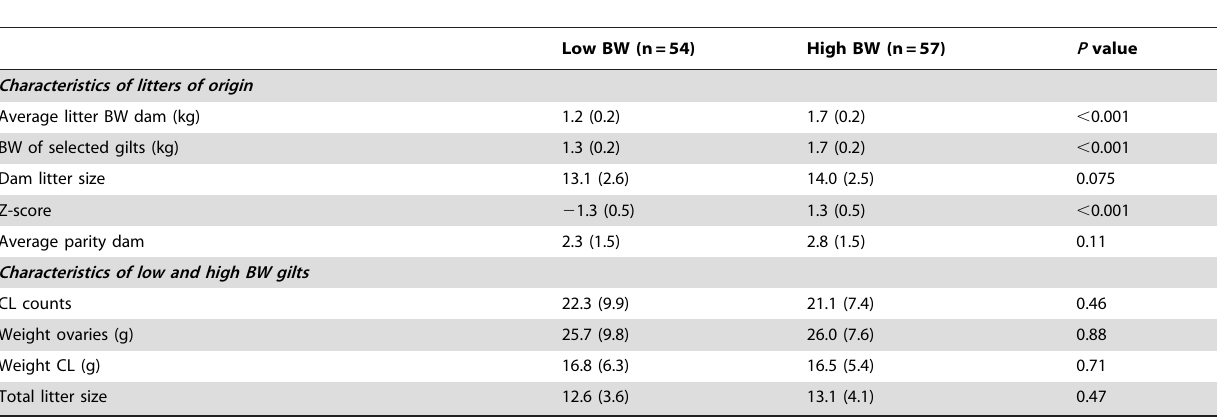
Table 1. Characteristics of litters from which the high and low gilts were selected and reproductive characteristics of the selected low and high BW gilts used in the